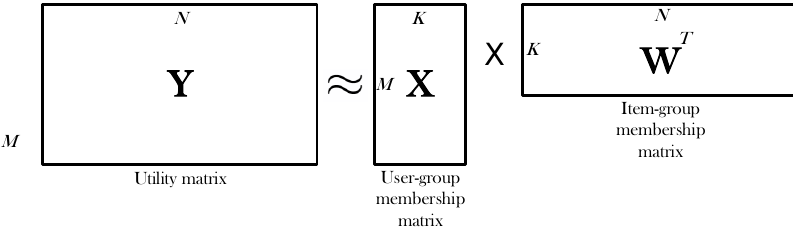
Figure 1. Decomposing utility matrix into two